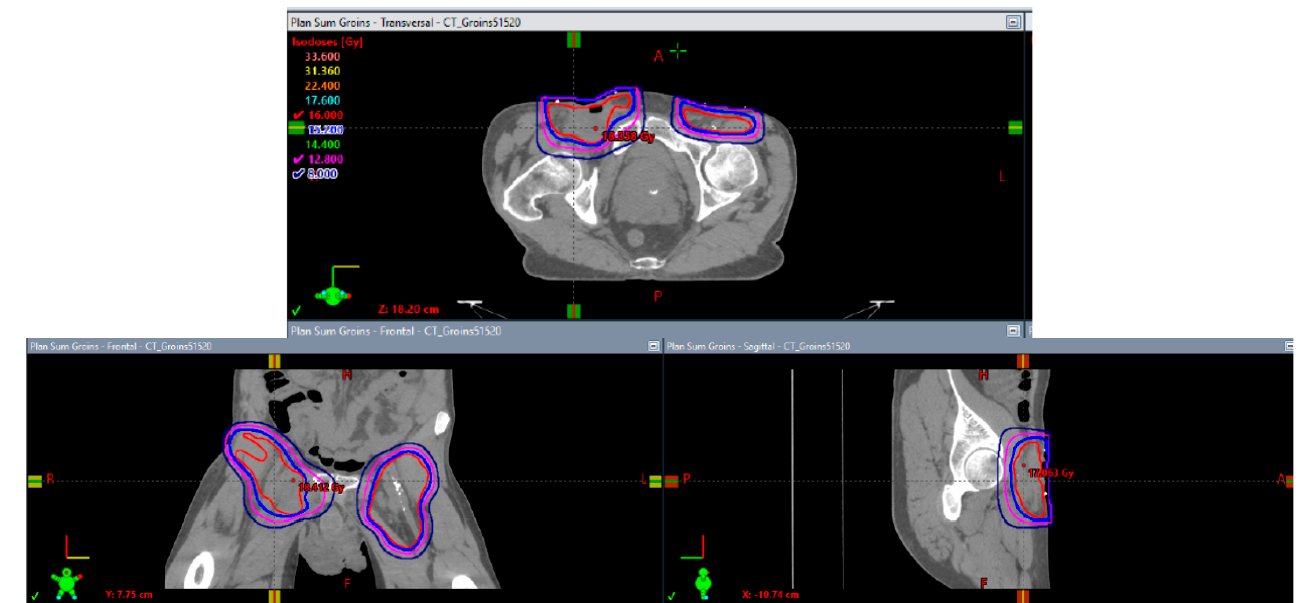
Figure 5. Axial, coronal, and sagittal isodose displays of inguinal groin boost plan to 16 Gy in 8 fractions. Lines in red, blue, magenta, and navy correspond with 16 Gy, 15.2 Gy, 12.8 Gy, and 8 Gy, respectively.